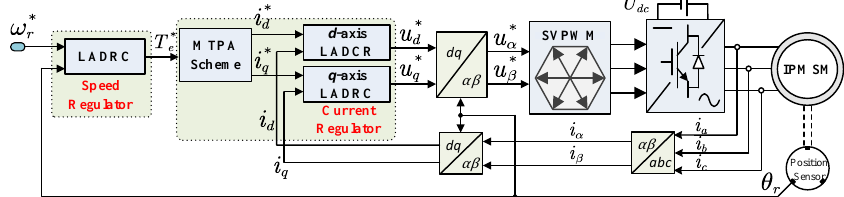
Figure 1. Diagram of the LADRC-based IPMSM drive system with an MTPA scheme.